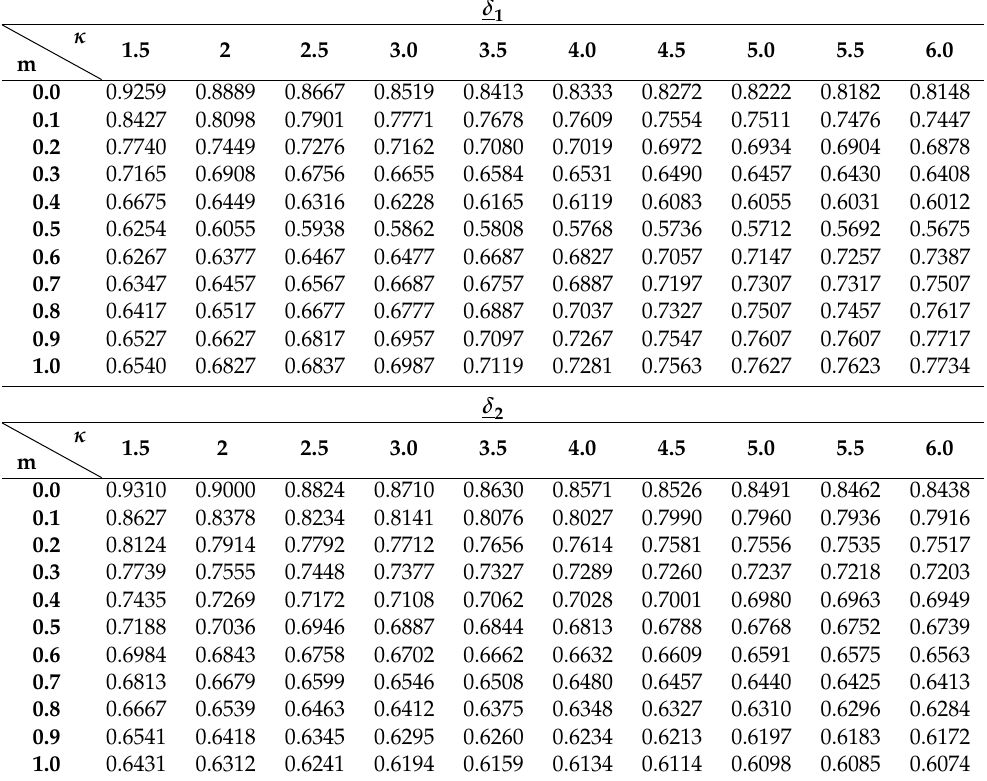
Table A4. Changes in the critical discount